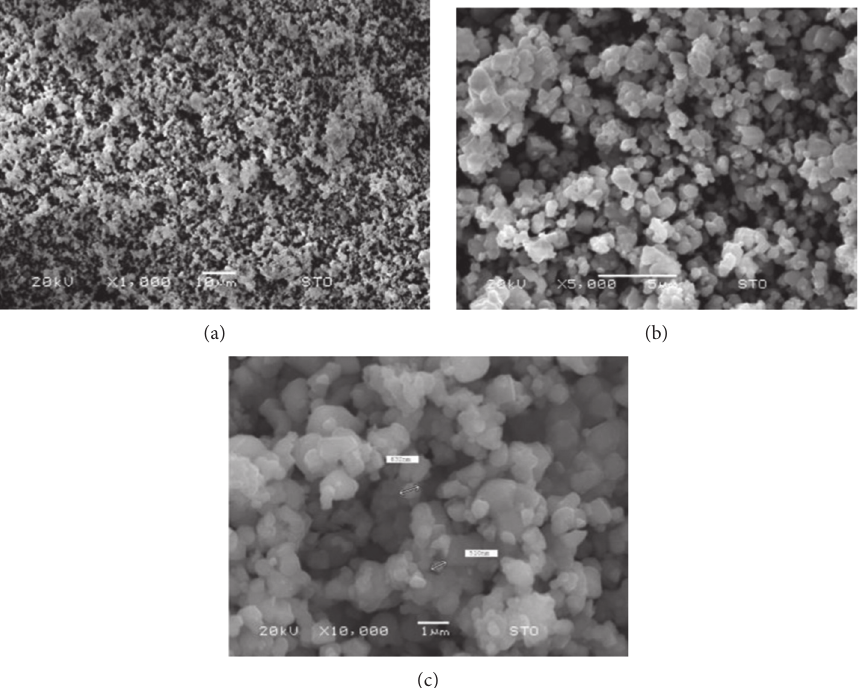
Figure 2: Micrographs of tausonite irradiated at 12000kGy. (a) 1000x, (b) 5000x, and (c) 10000x.